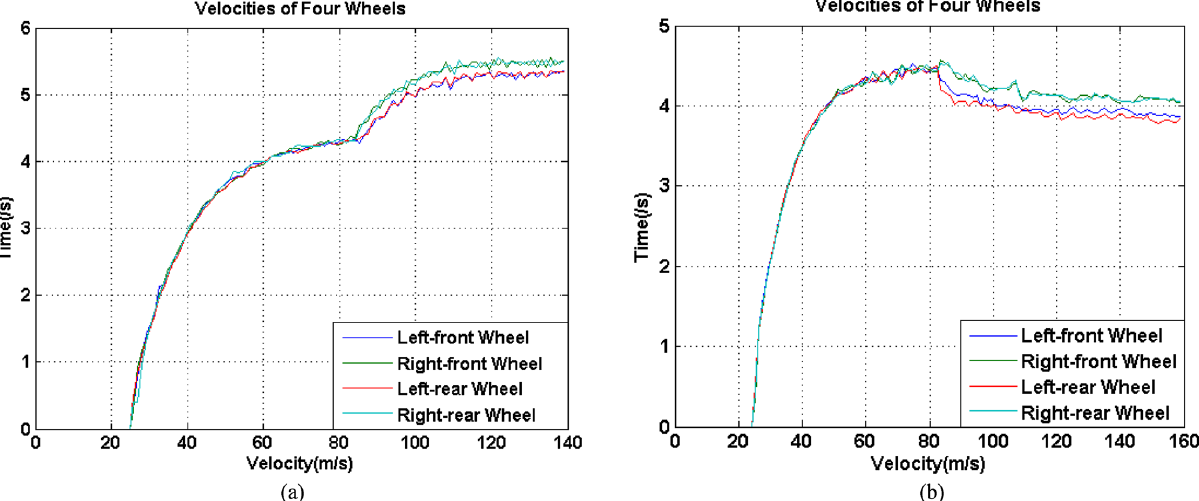
Figure 5. Two arrays of velocities of four wheels: ( a ) Overall velocity increased during the turning process, ( b ) overall velocity decreased during the turning monitor the variation of central angle, which was a yaw angle of the UGV with a high accuracy, changing with the variation of velocities of wheels during the process. Figure 6 shows the variations of yaw angles of above two experiments during the turning process. Both of the two yaw angles were increased with two corresponding approximately constant slope, which meant that the differences between V xi and V xo of the two experiments were so stable. In addition, it can be observed that during the same duration, the yaw angle variation in Fig. 6b was obviously higher than that in Fig. 6a. It could be derived that the velocities difference between inner and outer wheels in the condition that overall velocity decreased during the turning process was higher than that of overall velocity increased during the turning process, which was coincide with the presentation in Fig. 5a and b. According to Fig. 3, every stable outer trajectory and inner trajectory can correspond to their individual turning radii, whose error was the width of the UGV, i.e. B . Hence, the velocities can be used to calculate the lengths of the outer and inner trajectories, and then combining the variation in the yaw angle, then an actual B can be calculated. The corresponding mathematical description is shown in Eq. (13):